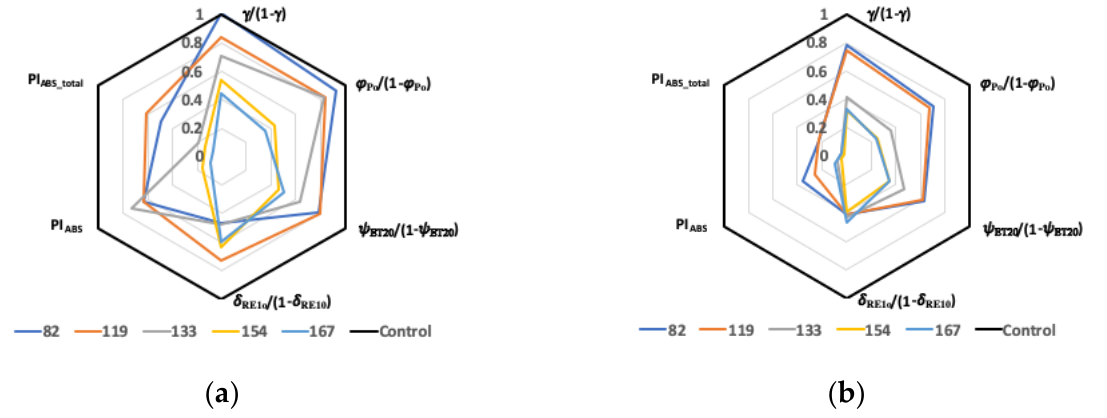
Figure 4. Spider plots of PI ABS , PI ABS_total , and their components RC/ABS = γ RC2 /(1 − γ RC2 ), ϕ Po /(1 − ϕ Po ), ( ψ ET2o /(1 − ψ ET2o ) and ( δ RE1o /(1 − δ RE1o ) in QA ( a ) and CG ( b ) from DAT 82 to DAT 167. Values are shown as the ratio S120/S0. The thicker line indicates the relative value (=1) for the control plants (S0).